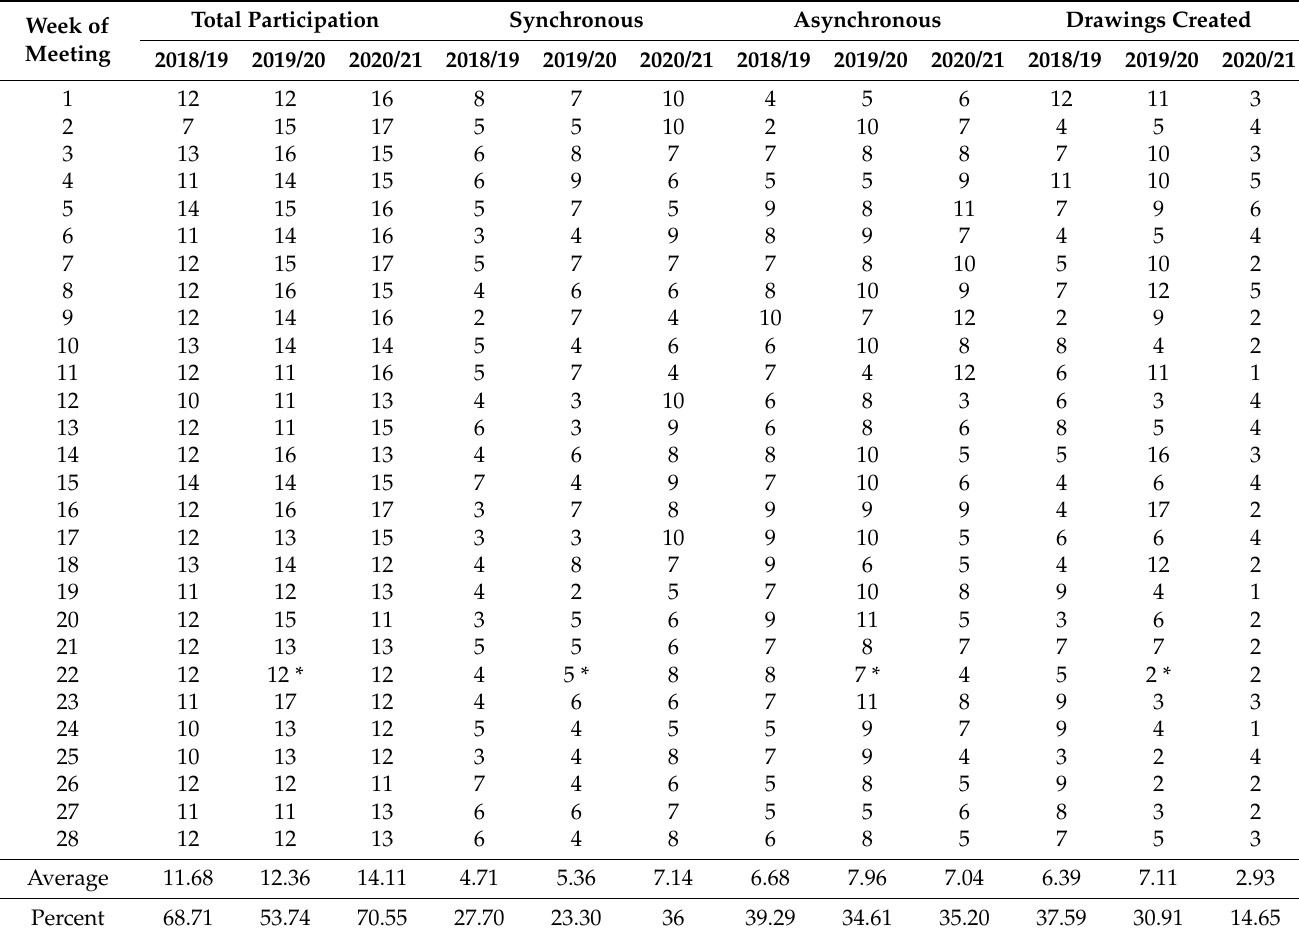
Table 6. Response to the Weekly Writing Prompts in Total Participation, Synchronous Participation and Asynchronous Participation Plus Response to the Weekly Requests for Doodles in Drawings Created during the Health Narratives Research Group, Both in Person and Online (Through the Private Facebook Group), over the Three Most Recent Academic